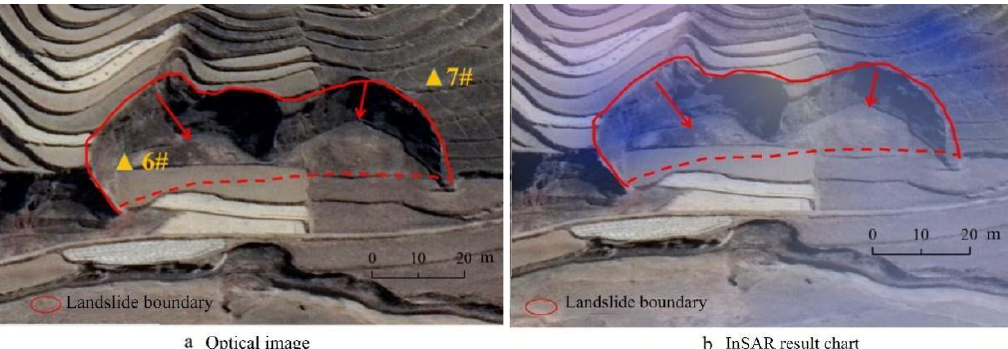
Figure 4. Jiaowan landslide. (a) optical image; (b) InSAR result chart.